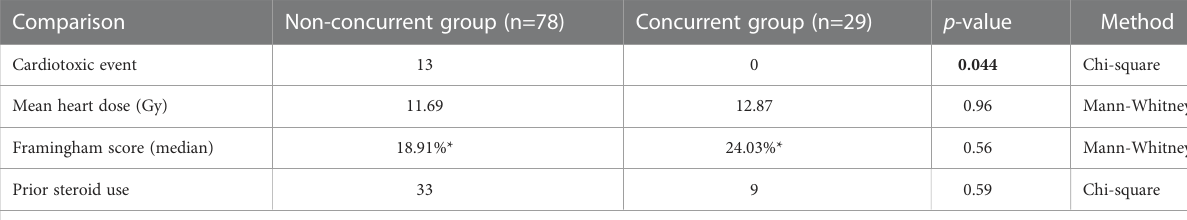
TABLE 7 Univariate analysis between patients who received ICI concurrently versus non-concurrently with thoracic RT.